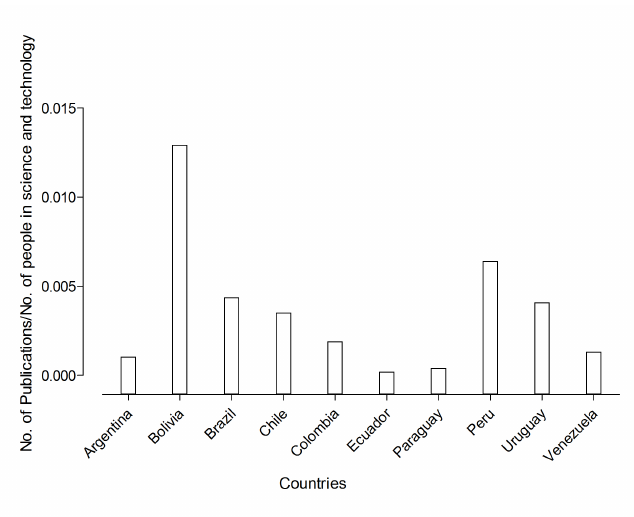
Figure 1. Distribution of the total number of publications in sports science by country with respect to people related to science and technology